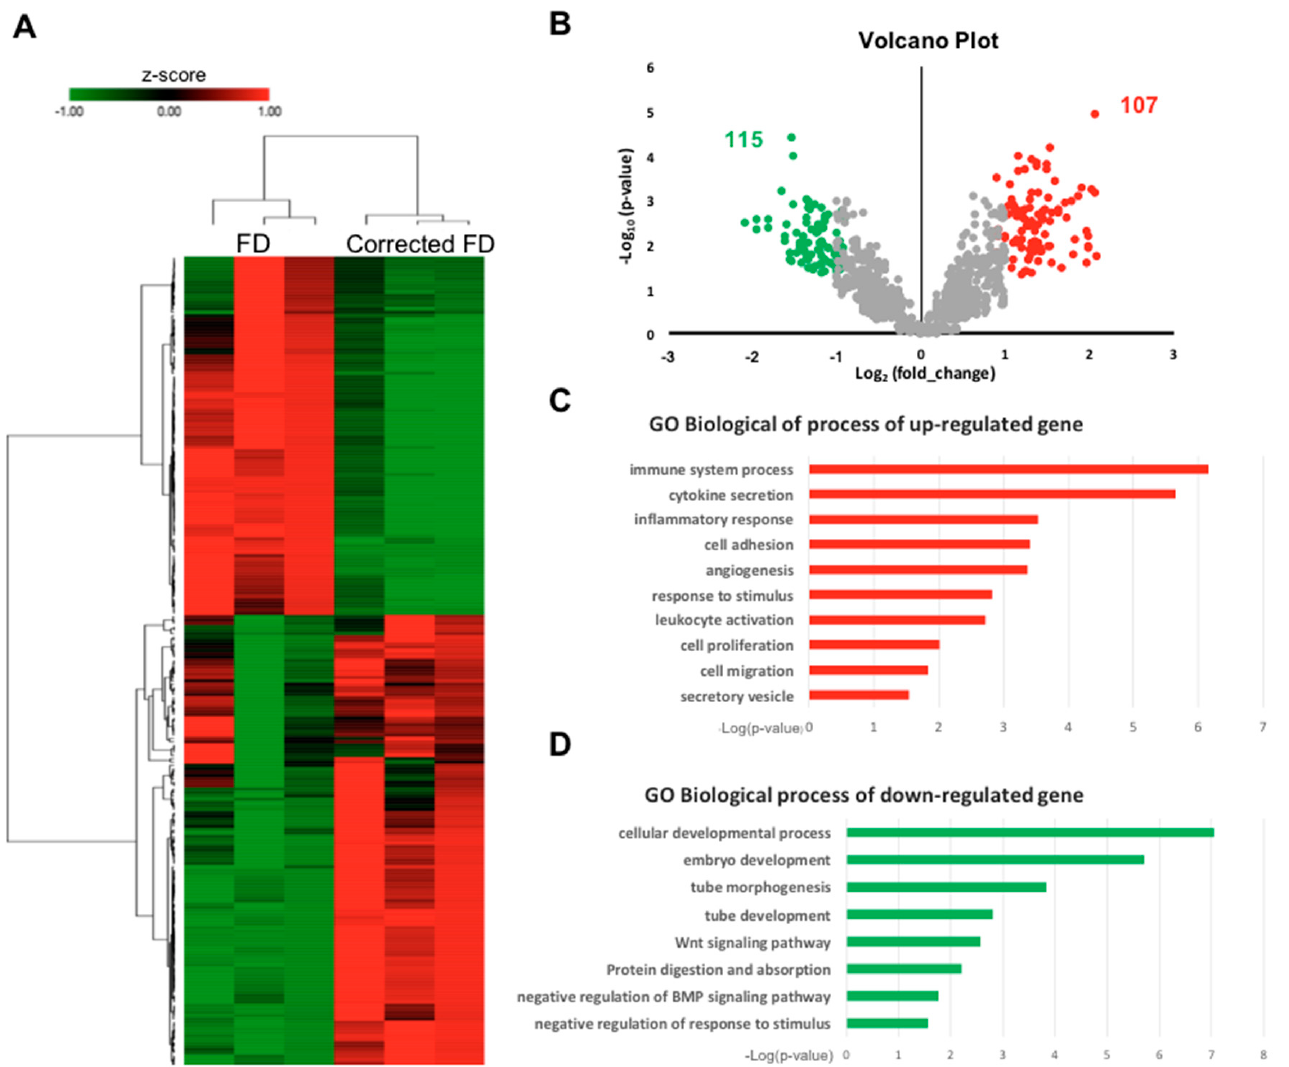
Figure 4. Differential expression analyses of corrected FD and FD-ECs derived from iPSCs. ( A ) Heatmap representing relative expression levels of the differential expression genes (DEGs) in corrected FD versus FD-ECs with fold change ≥ 2 up or down on average in both lines. Samples (in columns) and genes (in rows) are clustered by similarity. Shades of red represent upregulation, shades of green represent downregulation. Z score refers to the expression level of the indicated genes. ( B ) Volcano plot reveals 107 DEGs in red plot with fold of induction ≥ 2 and 115 DEGs in green plot with fold of reduction ≤ 2 in FD-ECs versus isogenic control. ( C ) Gene ontology (GO) pathway analysis of 107 DEGs are upregulated in FD-ECs versus isogenic control. ( D ) In gene ontology (GO) pathway analysis, 115 DEGs are downregulated in FD versus isogenic control ECs. The p -values were calculated with Benjamini-Hochberg adjustment.